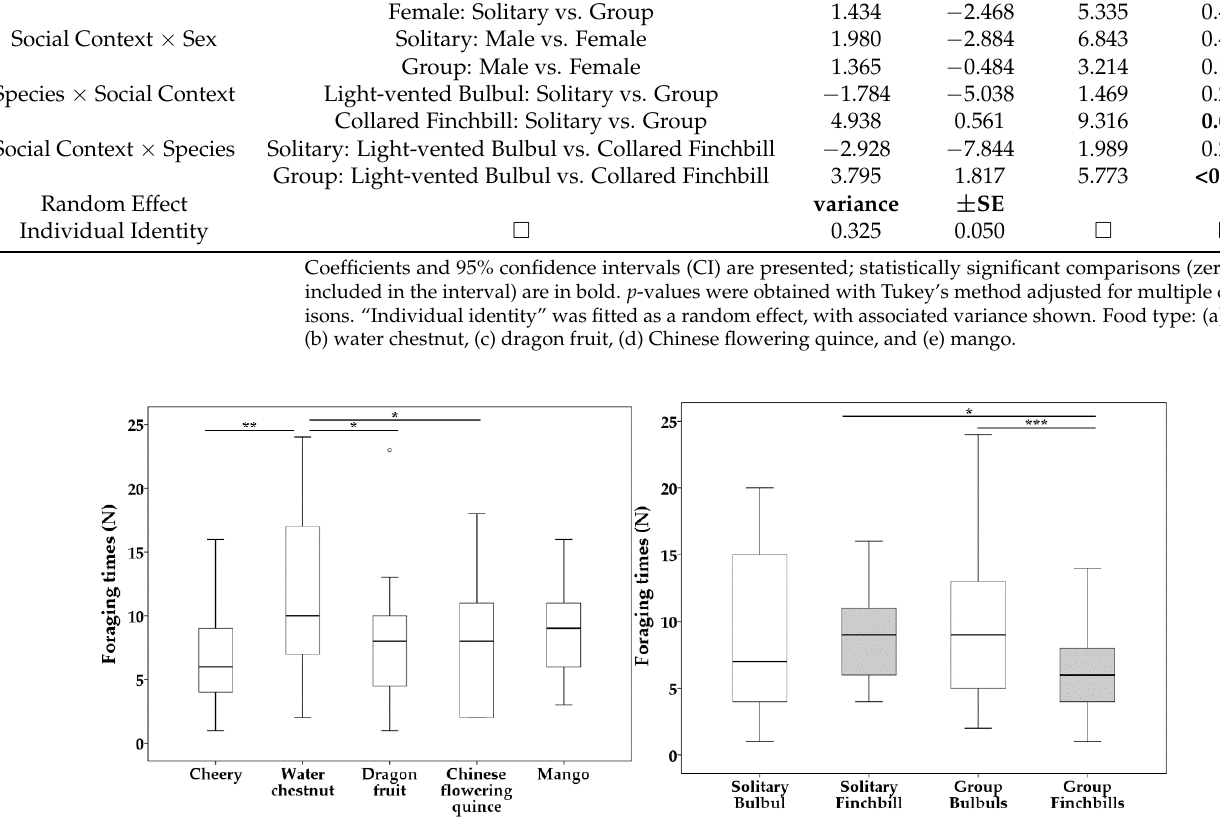
Figure 1. Boxplots of influence of novel food type ( a ) and species × social context ( b ) on foraging times (N) for Ligth-vented Bulbul (white bars) and Collared Finchbill (grey bars). Bars show the maximum observed value (upper part) and the minimum observed value (lower part). Line and asterisk(s) above the boxplots indicate statistically significant comparisons between the two groups. Upper edge of the box shows the upper quartiles (Q3), while the lower edge of the box shows the lower quartiles (Q1). The middle line in the box shows the median. Abnormal values are shown as small circles (for outliers) above the boxplots but under the line. *** p < 0.001. ** p < 0.01. * p <